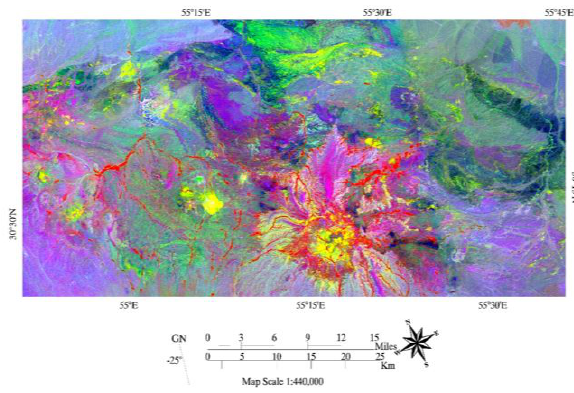
Figure 6. FCC image of RGB=MNF1, MNF2, MNF3, yellow color spots represent altered